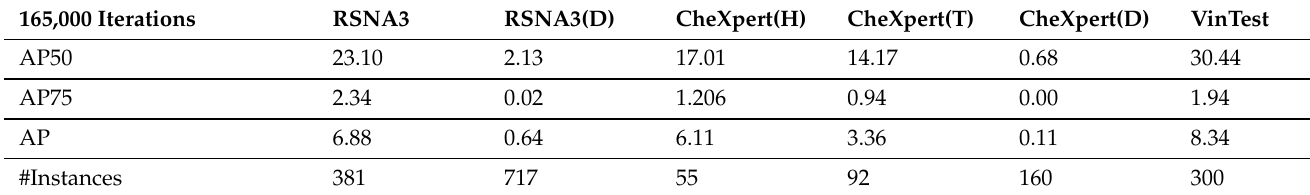
Table 4. Pneumonia detection training on VinBig and